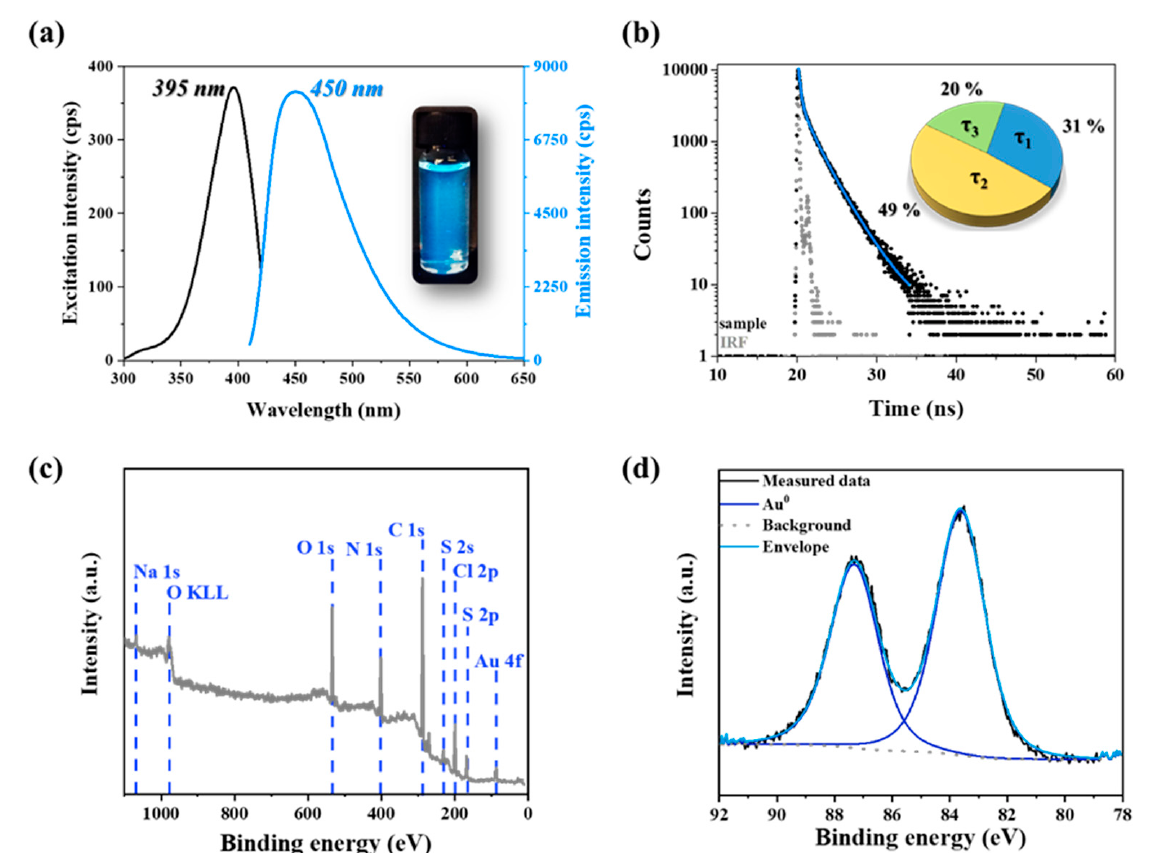
Figure 1. ( a ) The excitation and emission spectra of the B 1 -Au NCs with the photo of the sample under UV lamp ( λ max = 365 nm). ( b ) The typical fluorescence decay curve of the B 1 -Au NCs with the distribution percentage of the main lifetime components ( λ ex = 371 nm). ( c ) The survey scan and ( d ) the XPS spectra of the Au content in B 1 -Au NCs.